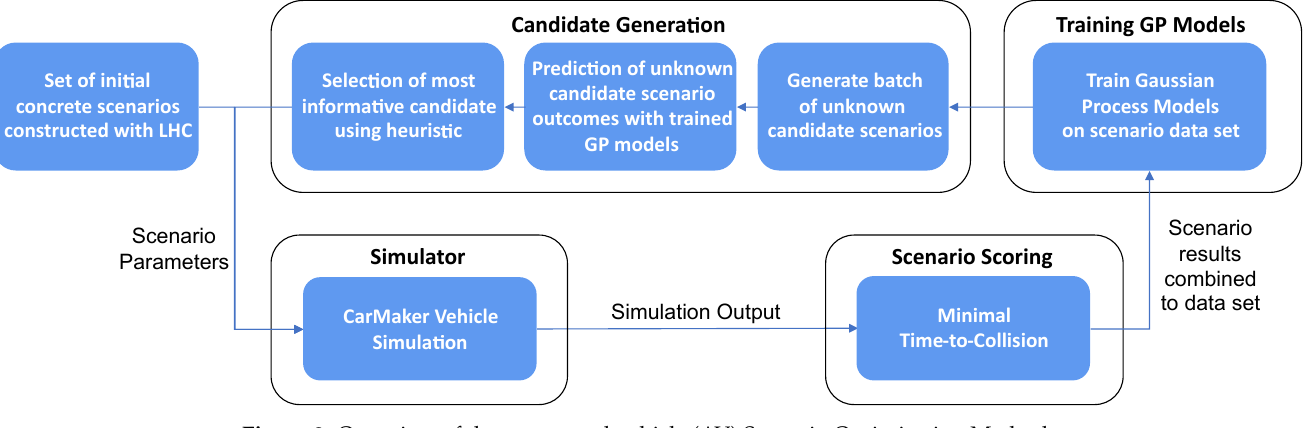
Figure 2. Overview of the automated vehicle (AV) Scenario Optimisation